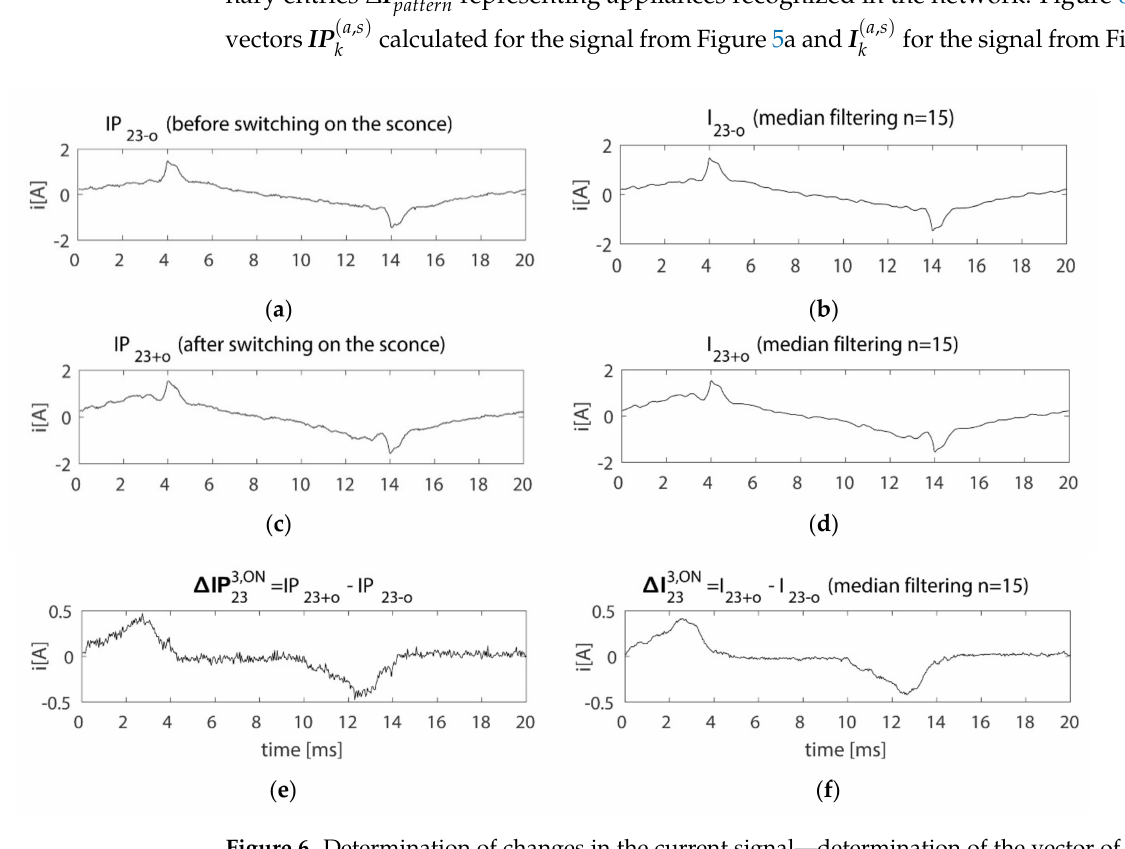
( a , s ) on the filtered signal median of k